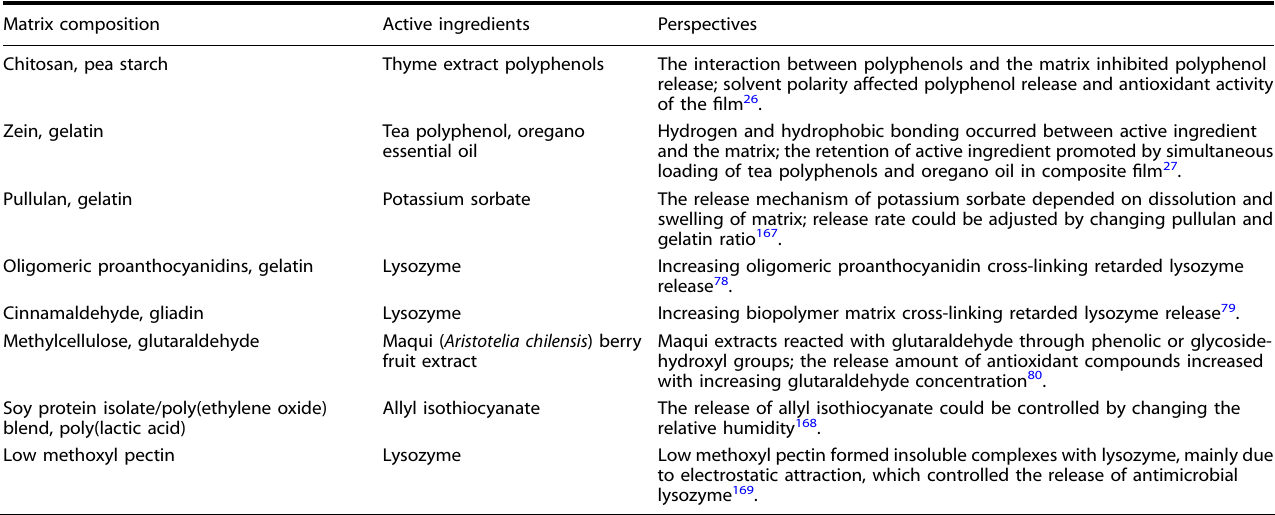
Table 3. Advanced examples of active degradable packaging materials assembled from sandwich-like molecules. Matrix